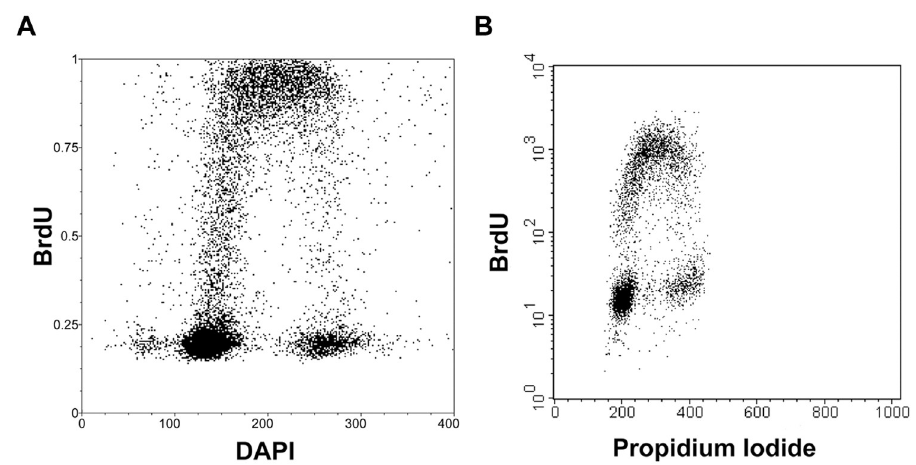
Fig 5. Determination of cell cycle by image and flow cytometry. (A) The bivariateanalysisof the replication signal and DNA content by DAPI in HeLa cells after a 30-minute incubationwith 10 μ M BrdU using image cytometry. ( B) The bivariateanalysisof the replicationsignaland DNA content by propidiumiodidein A549 cells after a 30-minute incubationwith 10 μ M BrdU using flow cytometry.